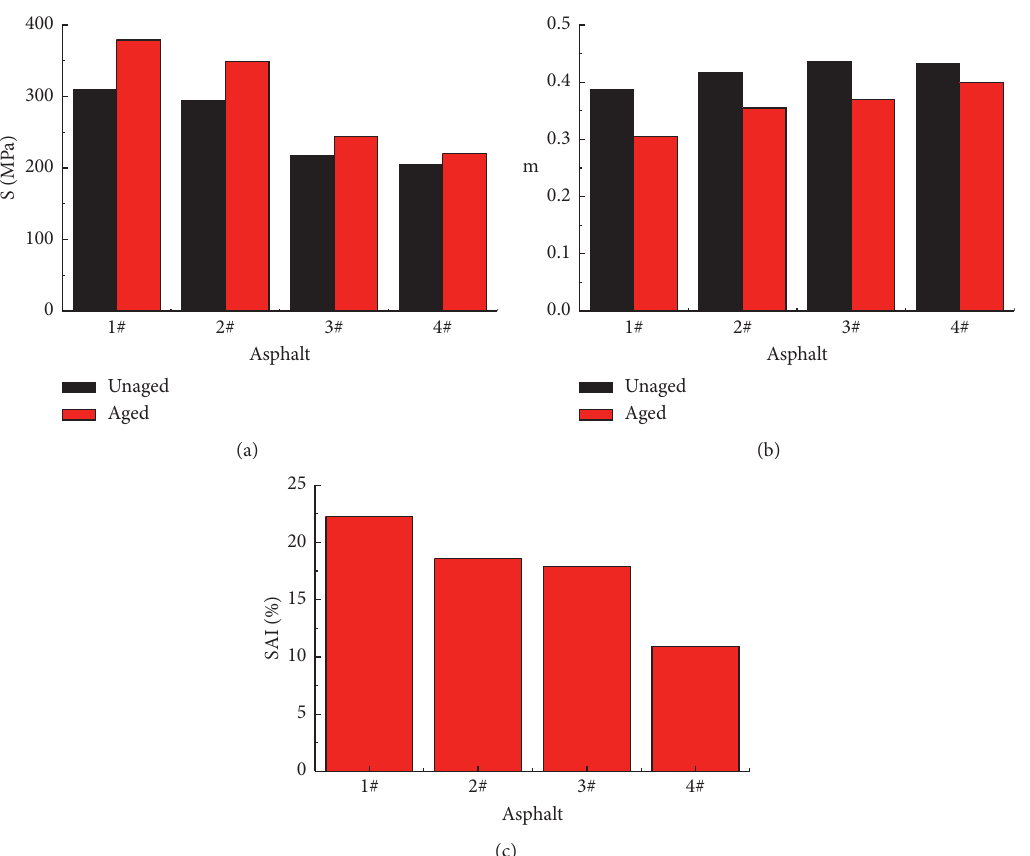
Figure 5: These parameters of the UV antiageing properties on base asphalt and modified asphalt. (a) Creep stiffness ( S ). (b) Creep rate ( m ). (c) The creep stiffness ageing index